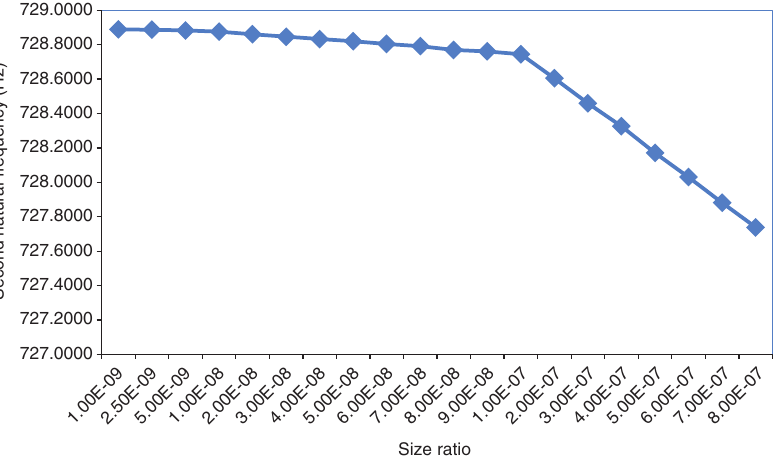
Figure 22: Variations of the second natural frequency of the simply supported beam with size ratio.